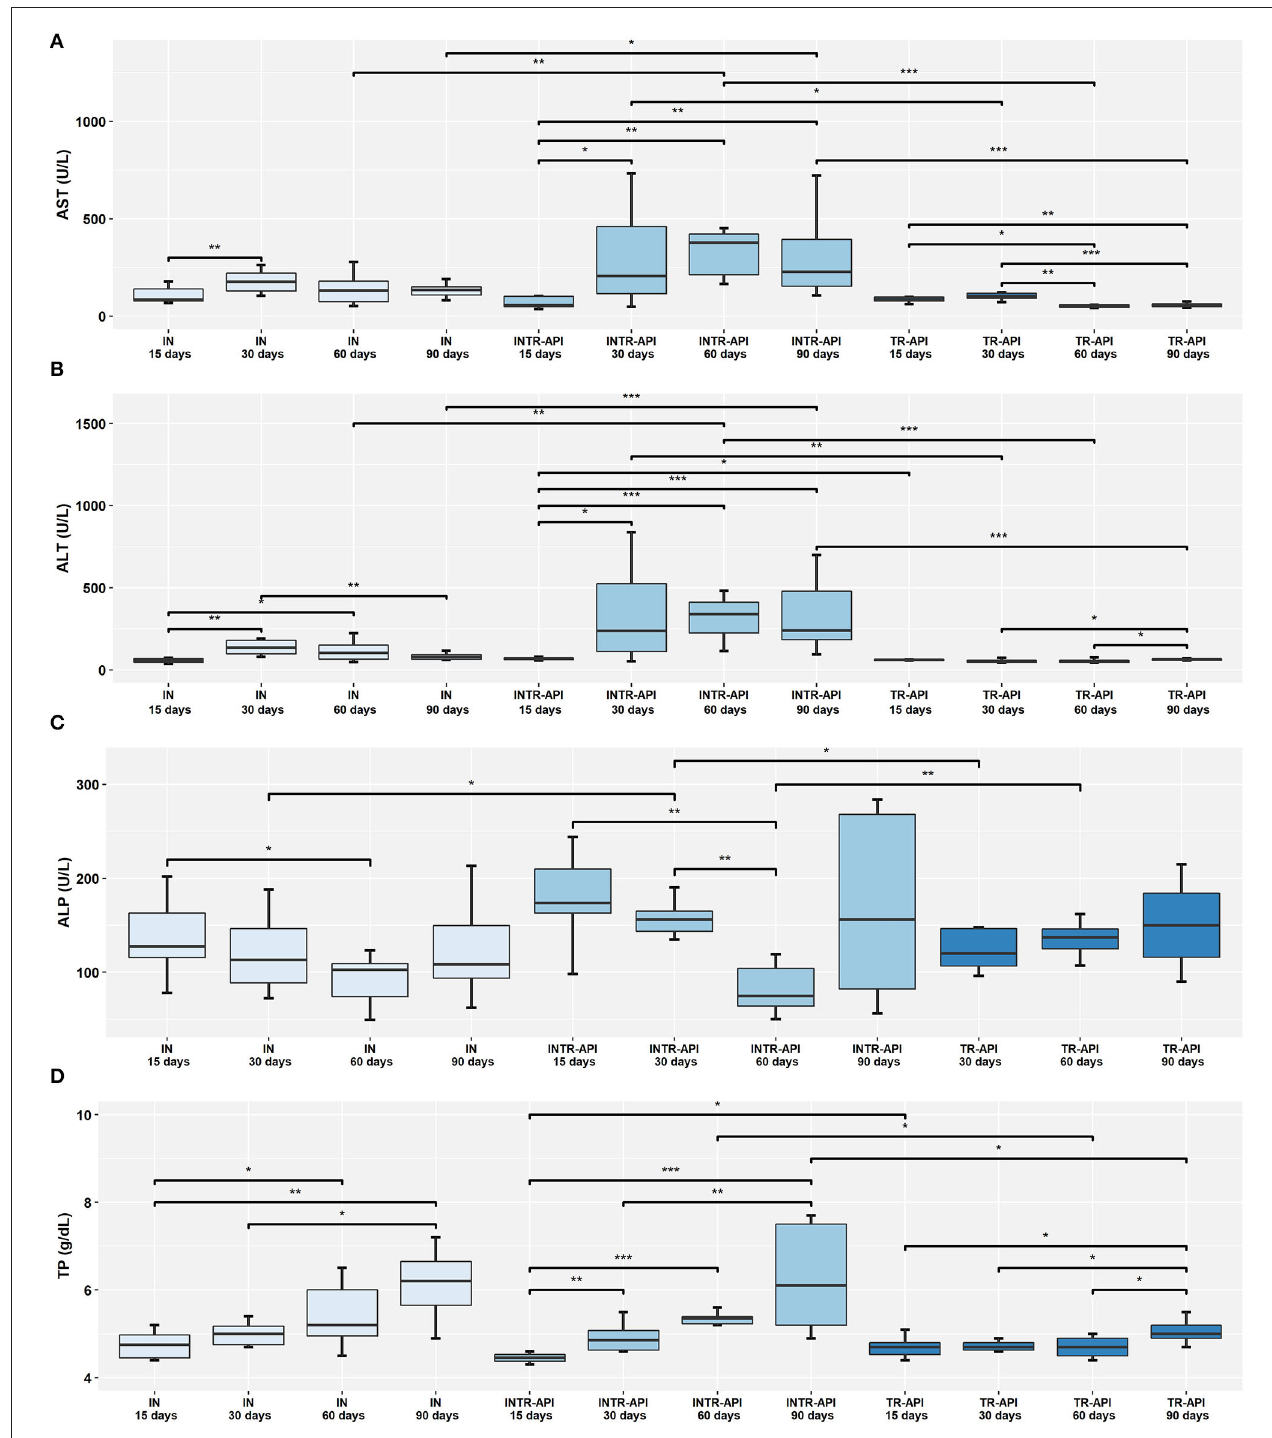
FIGURE 2 | Comparison of the results of serological parameters between the IN, INTR-API and TR-API groups. (A) AST, Aspartate Transaminase; (B) ALT, Alanine Transaminase; (C) ALP, Alkaline Phosphatase; and (D) TP, Total Proteins. Mann-Whitney-Wilcoxon test: * P < 0.05, ** P < 0.01, *** P < 0.001.